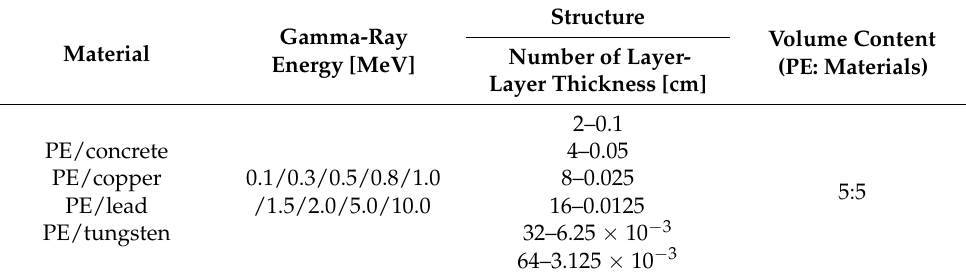
Table 1. Parameters used in MCNP simulation for film type laminated composites.